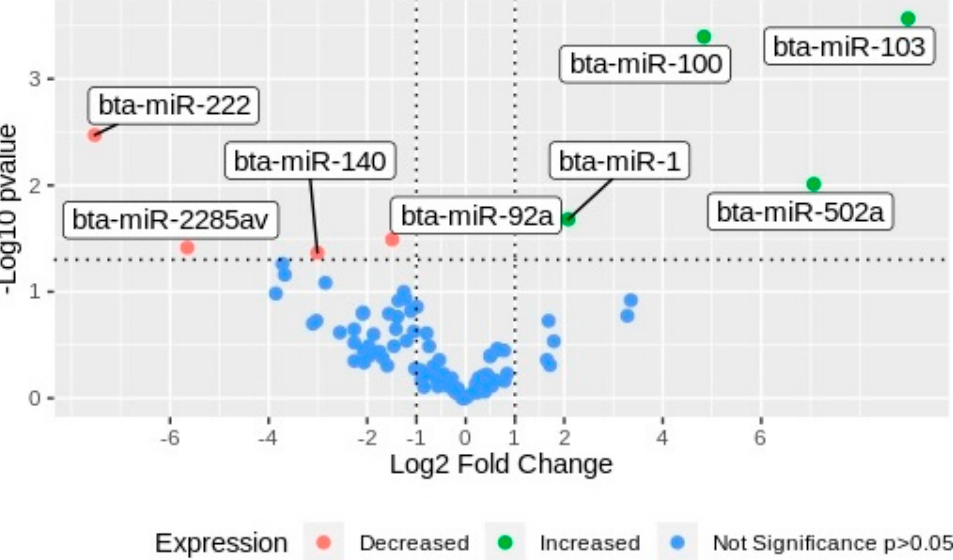
Figure 3. Volcano plot of miRNAs differentially expressed in EVs from embryos with different development potential. miRNAs were plotted according to the values of Log2 fold change in the horizontal bar against the Log10 of the p -values in the y-axis. Green dots, miRNAs upregulated in EVs secreted by arrested embryos (G1); red dots, miRNAs downregulated in G1; blue dots, miRNAs non-differentially expressed between groups.